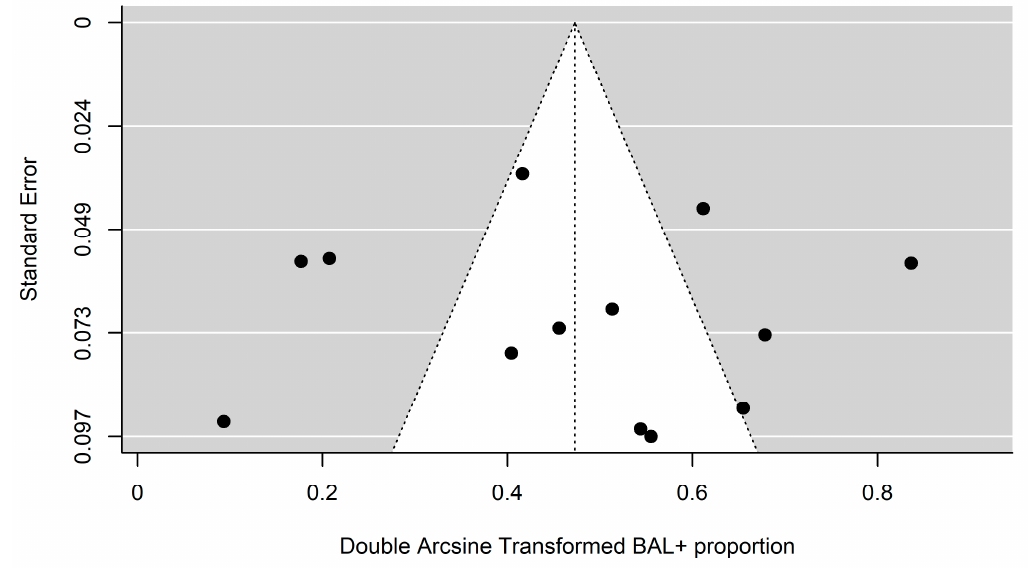
Figure 3. Contour-enhanced funnel plots for BAL.